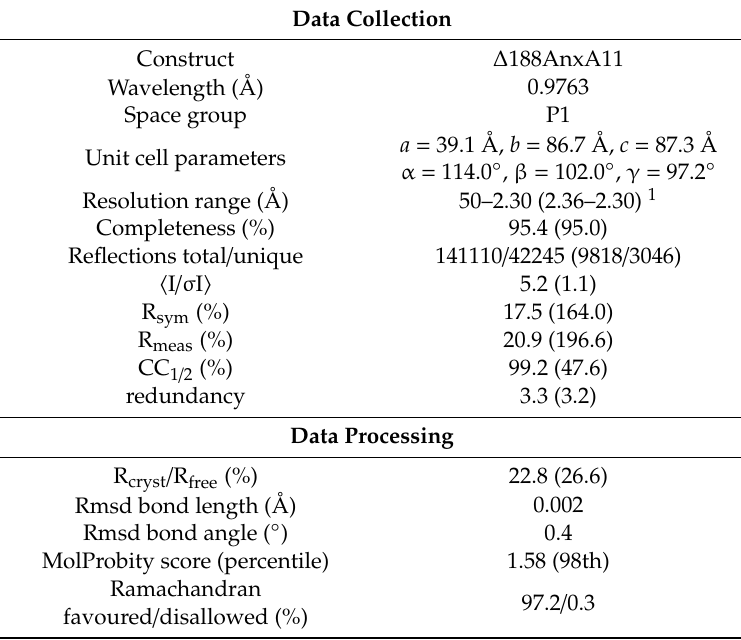
Table 2. Crystallographic data collection and